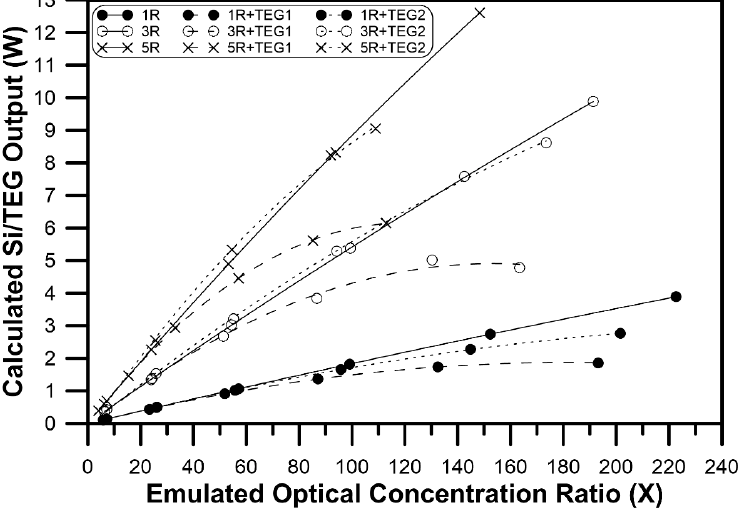
Figure 11. Total output of the LGBC silicon concentrator PV cell coupled to TEGs.